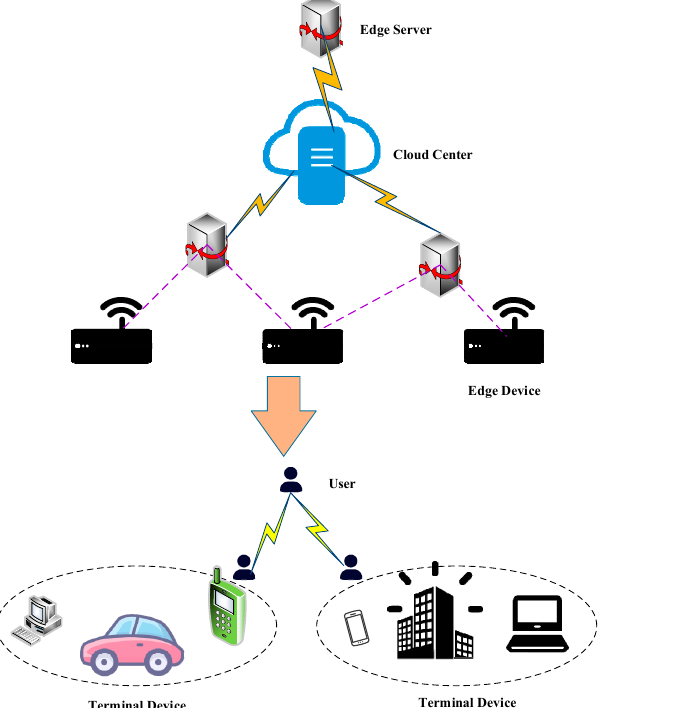
Figure 5. Structure of online power RAA. Algorithm 1: Distributed matching